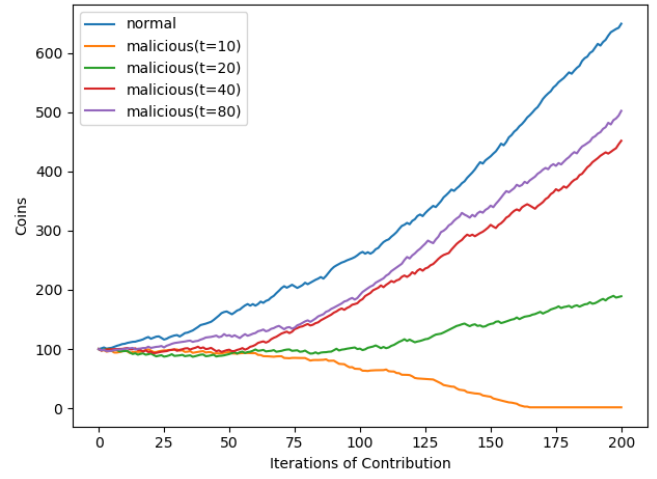
Figure 6. Changes of cryptocurrencies held by each contributor and attacker ( p =